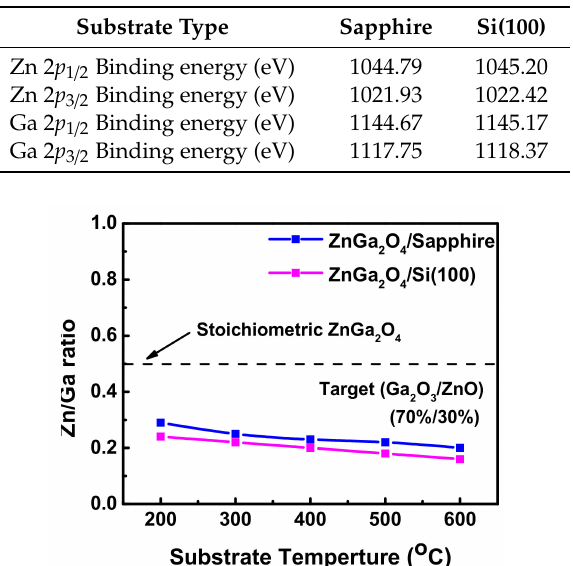
Figure 7. Variation Zn / Ga ratio vs substrate temperature for the deposited of ZnGa 2 O 4 / sapphire and ZnGa 2 O 4 /